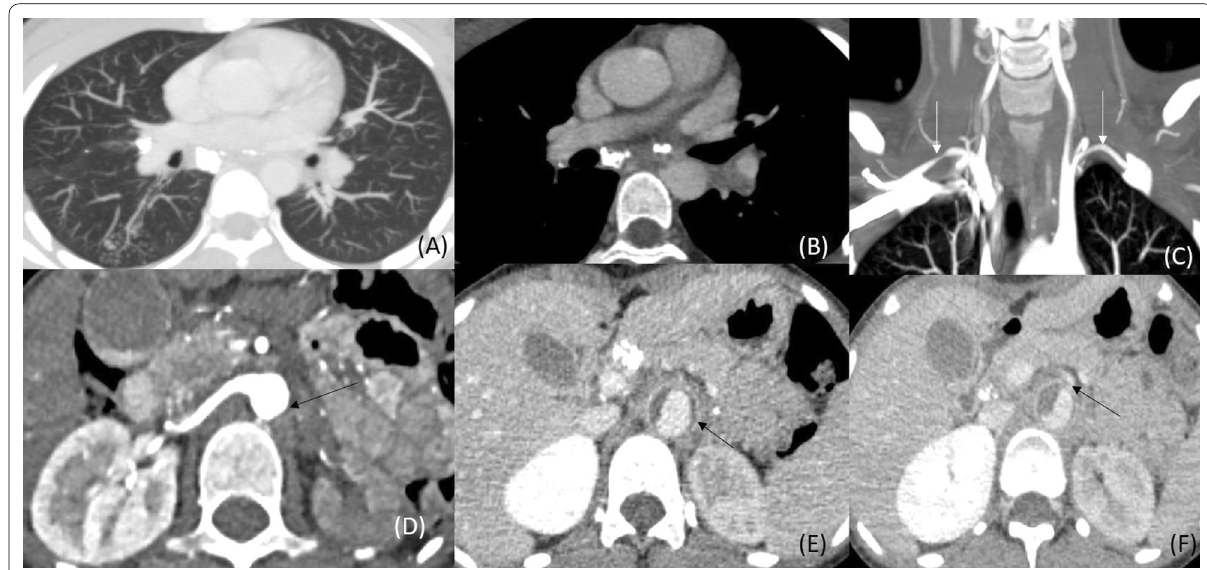
Fig. 19 Takayasu arteritis associated with TB. CT images of a 35-year-old female show tree-in-bud nodules ( A ), calcified mediastinal nodes ( B ), attenuated calibre of bilateral subclavian arteries ( C ), complete luminal obliteration of left renal artery ( D ), wall thickening with luminal thrombus in abdominal aorta (arrow in E ), calcified periportal nodes ( E ) and narrowing at ostia of superior mesenteric artery ( F ), reduced opacification of left renal parenchyma due to involvement of renal artery ( D – F )